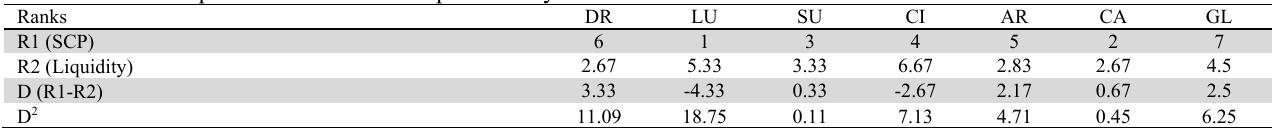
Relative relationship between av. SCP and